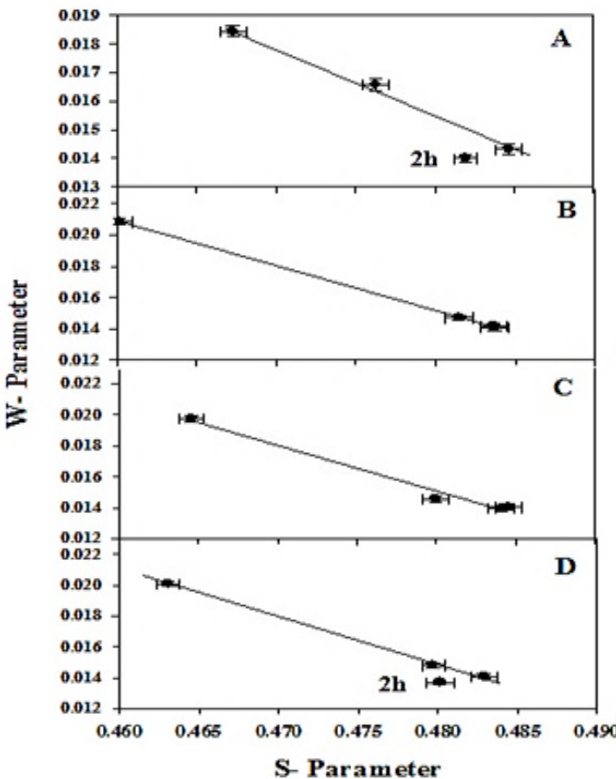
Figure 7. The S versus W plot for 7 g commercial silicon powder at sonication times of 2, 3 and 4 h with special conditions in different weights of KOH (wt.%): ( A ) at 6 wt.% KOH, ( B ) 4.5 wt.% KOH and ( C ) 3 wt.% KOH and ( D ) 5 g commercial silicon powder and 3 wt.% KOH. The solid line represents a linear fitting of the experimental data.